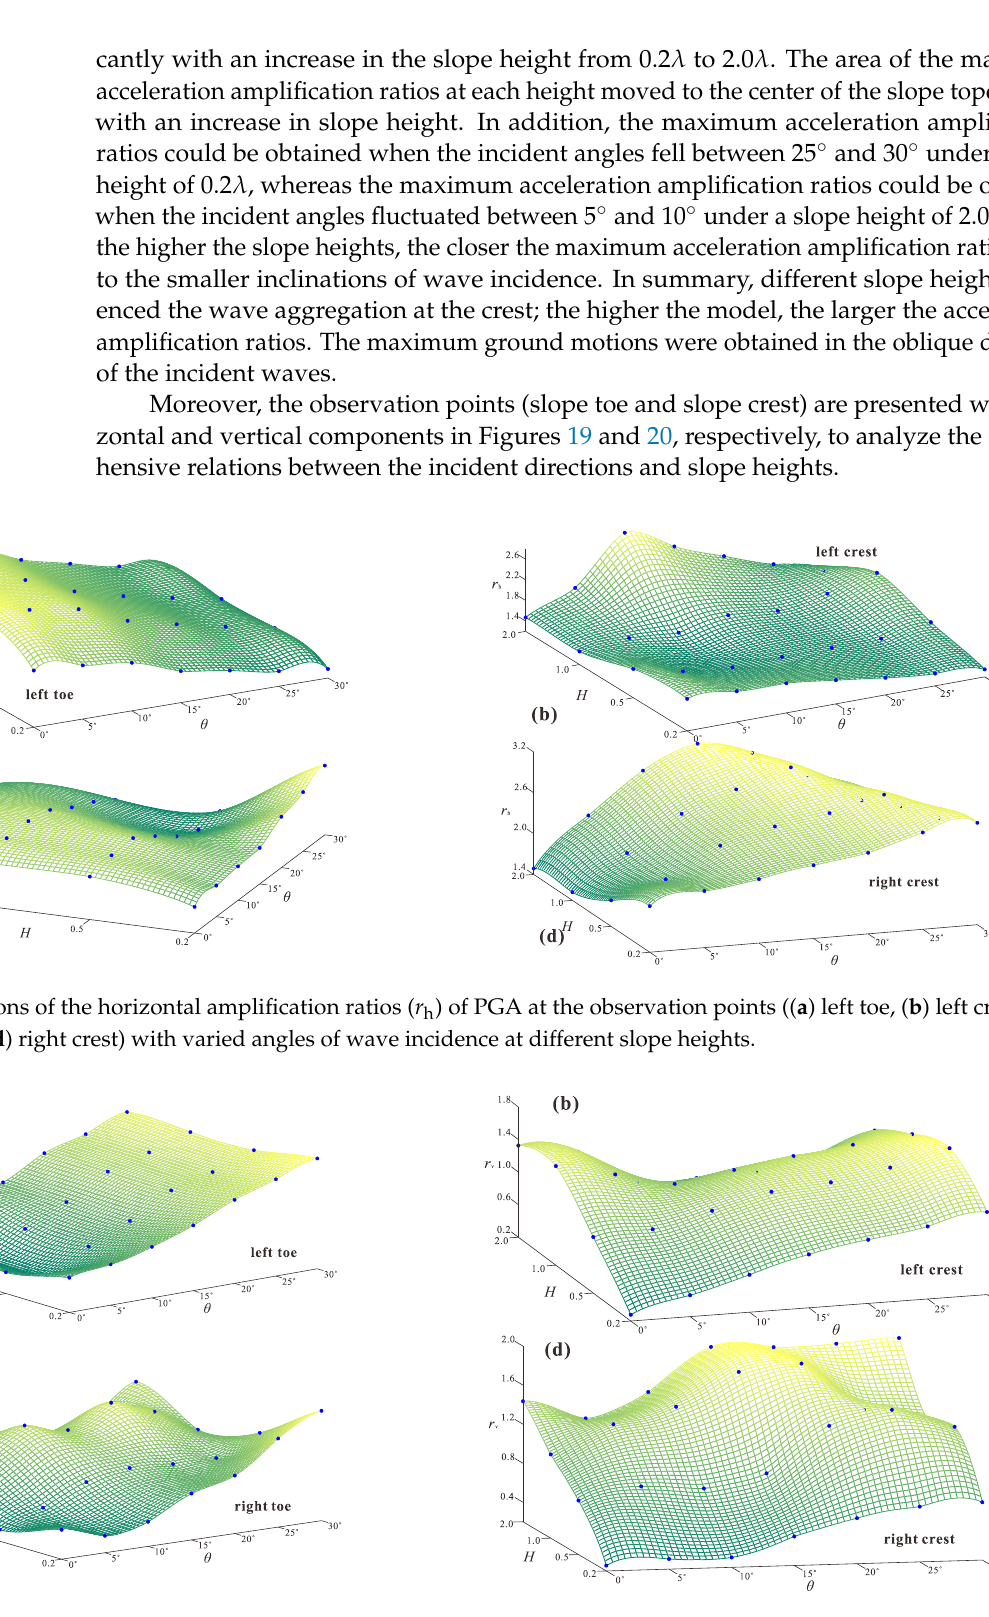
Figure 18. Variations of the seismic responses along the slope ridges and the slope crests of the real amplification ratio ( r ) of PGA with varied angles of wave incidence at different slope heights. ( a ) slope height of 20 m, ( b ) slope height of 50 m, ( c ) slope height of 100 m, ( d ) slope height of 200 m